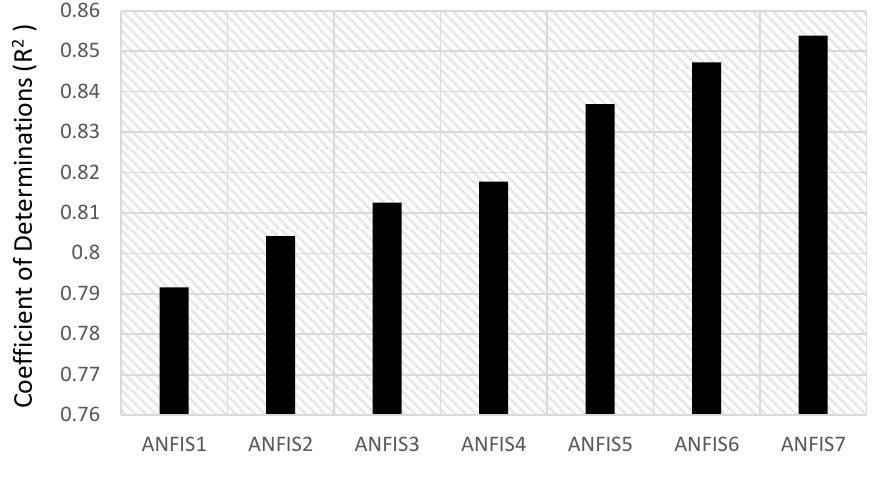
Fig. 19. Coefficient of Determinations (R 2 values) for ANFIS1, ANFIS2, ANFIS3, ANFIS4, ANFIS5, ANFIS6, and